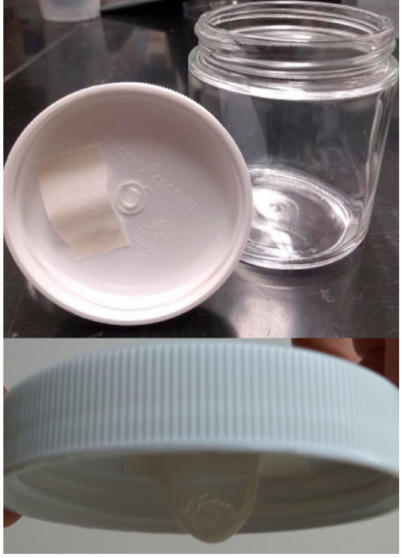
Figure 1. Thrips fumigation chamber with hydrogel